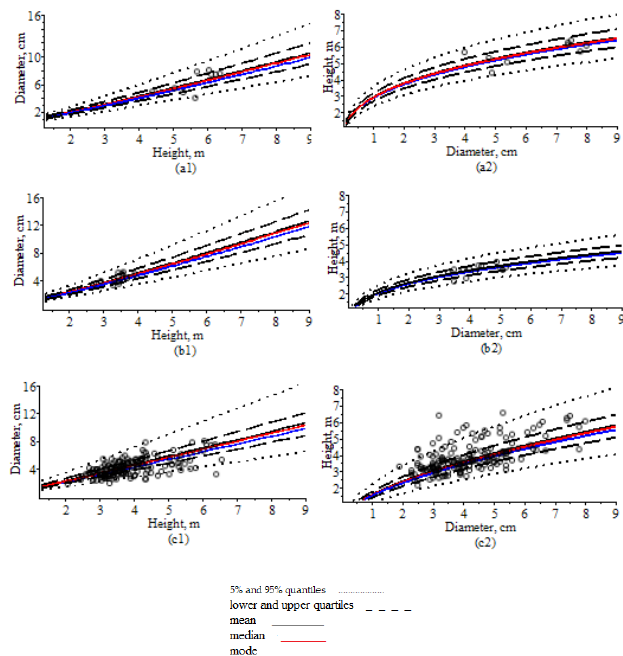
Figure 4. Dynamics of the stationary conditional mean, mode, median, 5% quantile, 95% quantile, and lower- and upper-quartile trajectories for two stands within the validation dataset: left panel—diameter–height models; right panel—height–diameter models; ( a1,a2 )—the first stand mixed-effect scenario; ( b1,b2 )—the second stand mixed-effect scenario; ( c1,c2 )—the fixed-effect scenario for all stands from the validation dataset; mean—solid line in black; median—solid line in red; mode—solid line in blue; 5% and 95% quantiles—dotted lines; lower and upper quartiles—dashed lines; values are shown by circles.